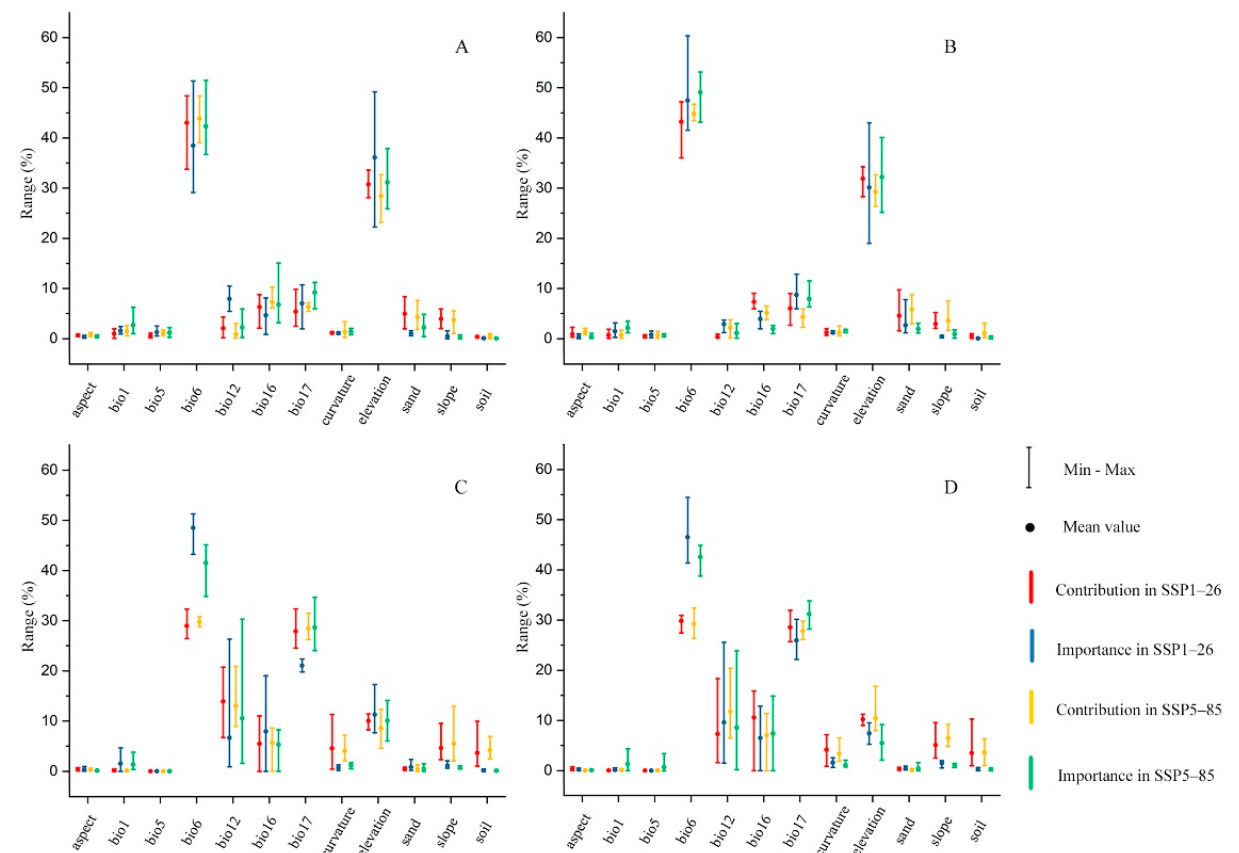
Figure 2. Contributions and importance of environmental factors in Maxent model. ( A ) Malus pumila Mill in 2050s, ( B ) M. pumila in 2090s, ( C ) Prunus armeniaca L. in 2050s, ( D ) P. armeniaca in 2090s.